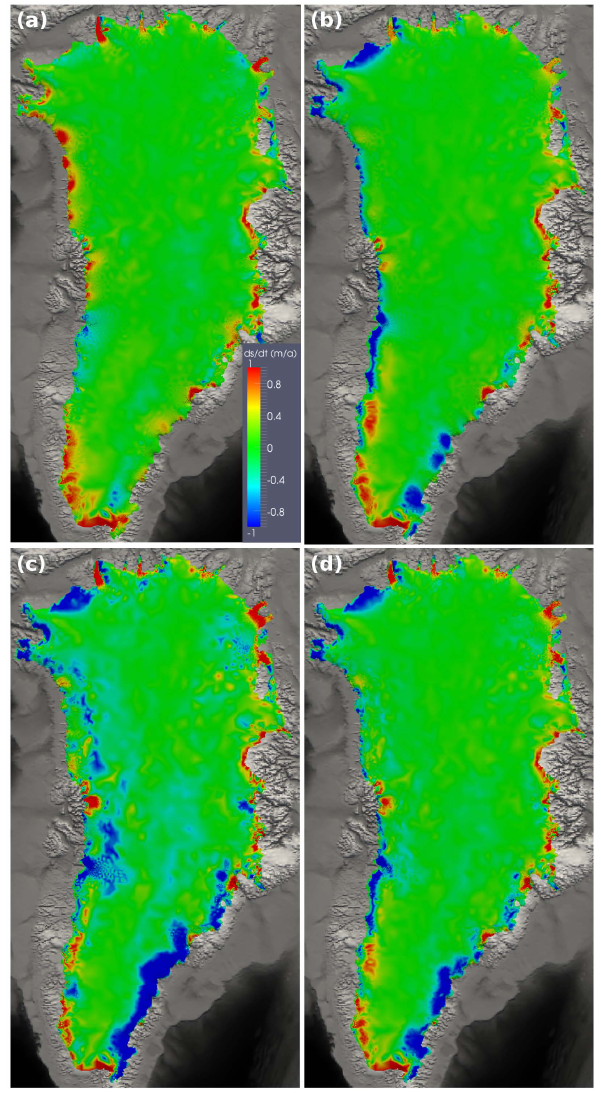
Fig. 9. Free surface elevation rate of change after 10yr for experi- ments (a) C1 BF1, (b) C2 BF1, (c) C2 BF2, and (d) C2